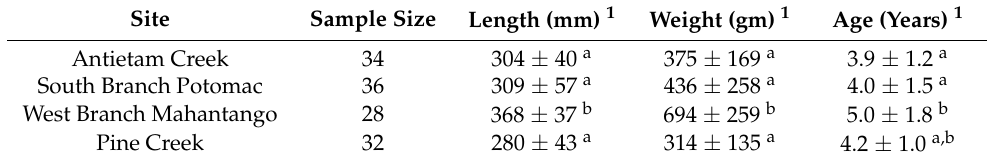
Table 2. Morphometric characteristics of smallmouth bass collected at four sites within the Chesa- peake Bay